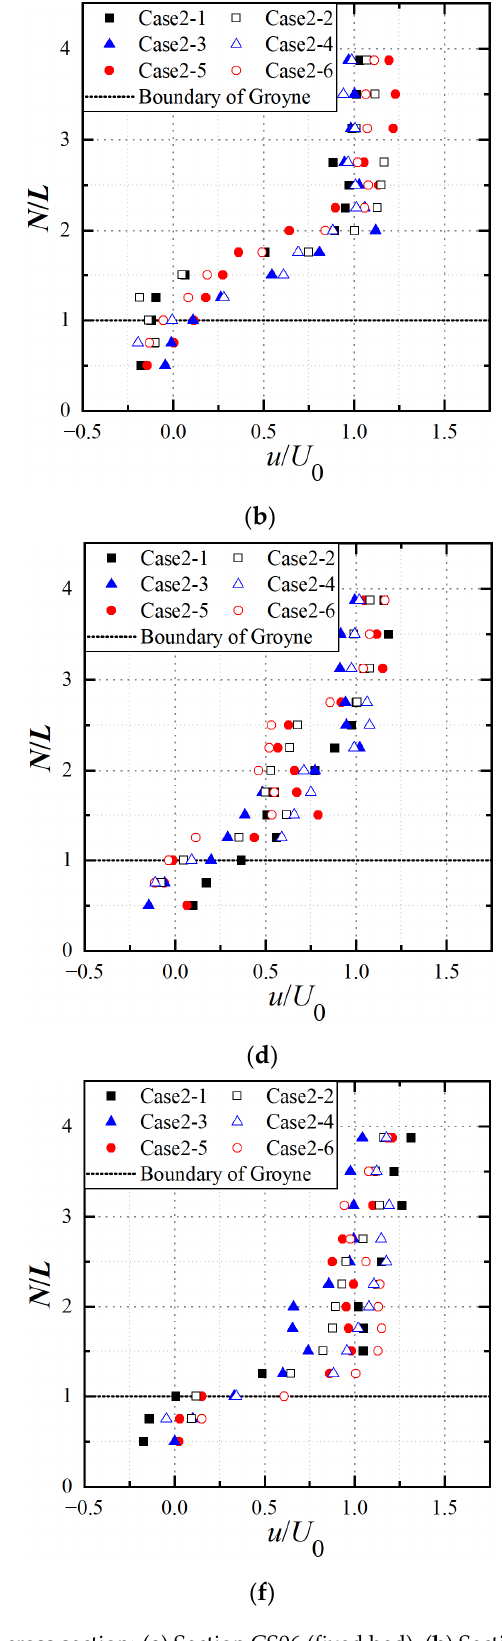
Figure 3. Velocity distribution in typical cross section: ( a ) Section CS06 (fixed bed), ( b ) Section CS06 (mobile bed), ( c ) Section CS10 (fixed bed), ( d ) Section CS10 (mobile bed), ( e ) Section CS14 (fixed bed) and ( f ) Section CS14 (mobile bed).